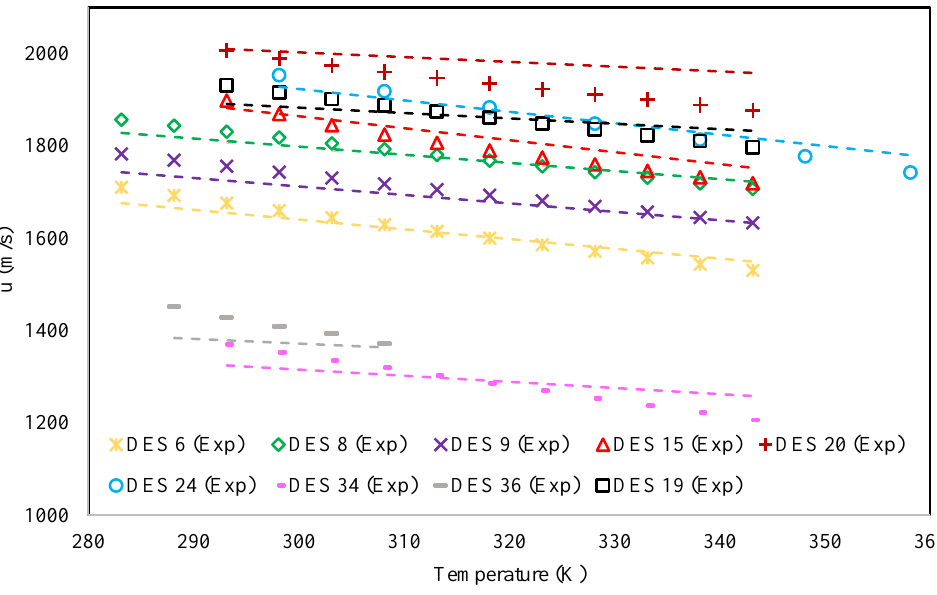
Figure 1. Comparison of the behavior of the speed of sound versus temperature for the proposed model and experimental data for nine randomly selected DESs.